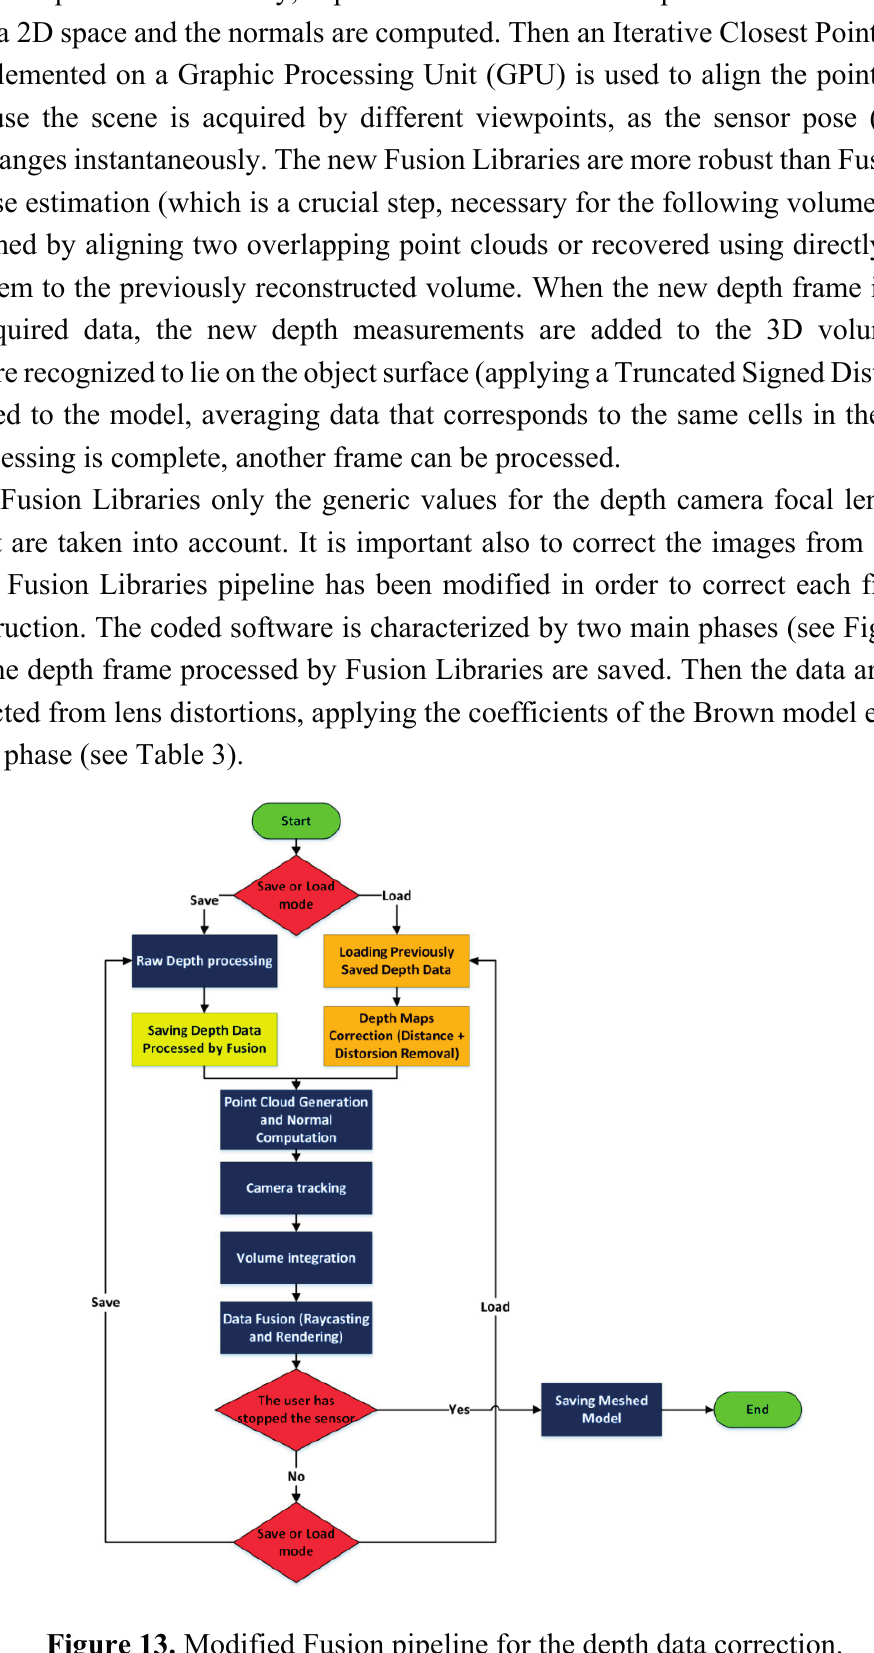
Figure 13. Modified Fusion pipeline for the depth data